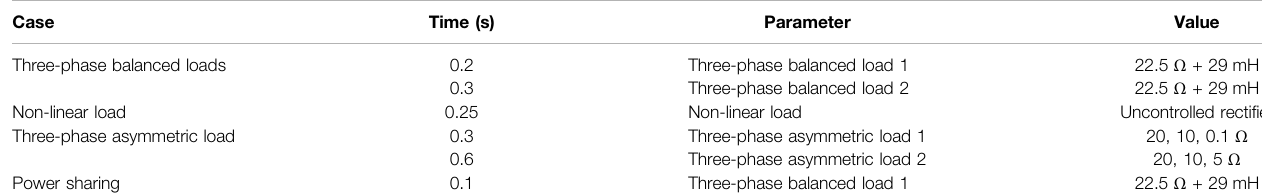
TABLE 2 | Load parameters of the microgrid inverter system.